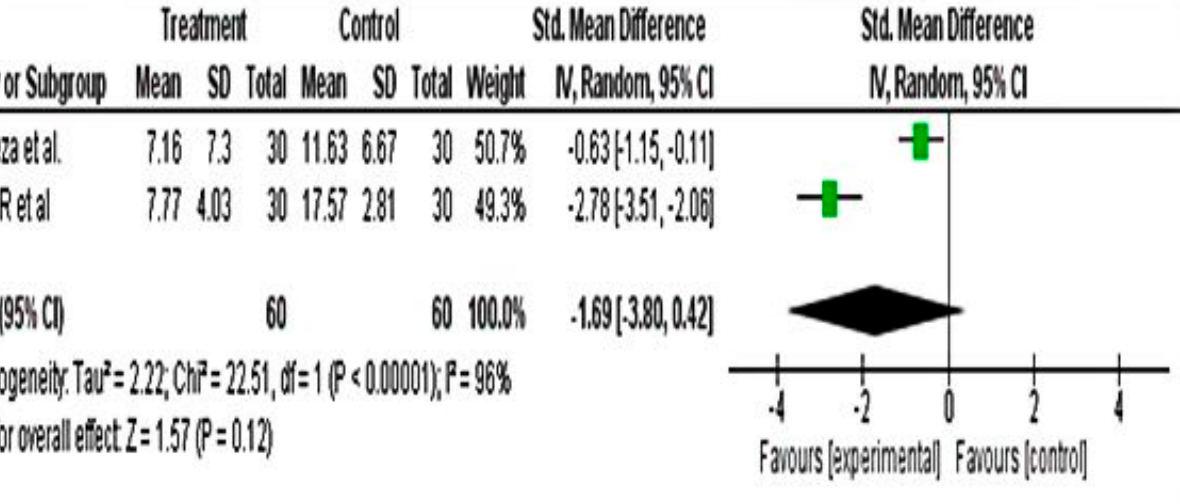
Figure 7. Forest plot for premenstrual screening tool using PMTS [46,52].